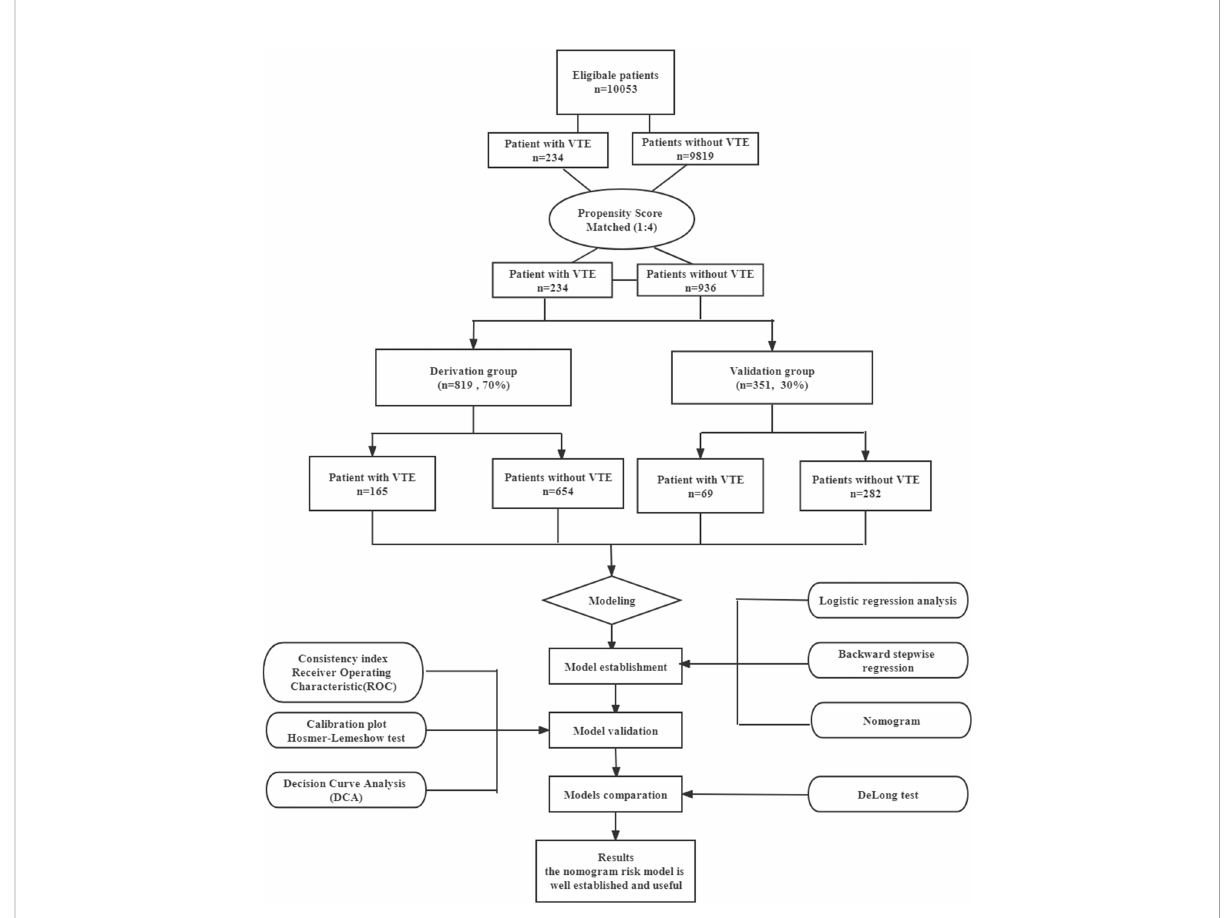
FIGURE 1 Flow chart of the study design and analysis. VTE, venous